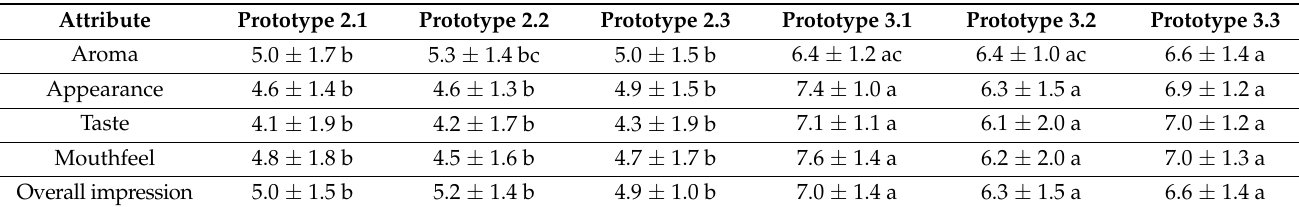
Table 6. General acceptability of prototypes 2.1, 2.2, 2.3, 3.1, 3.2 and 3.3. Note: values with the same letter are statistically equal ( t <